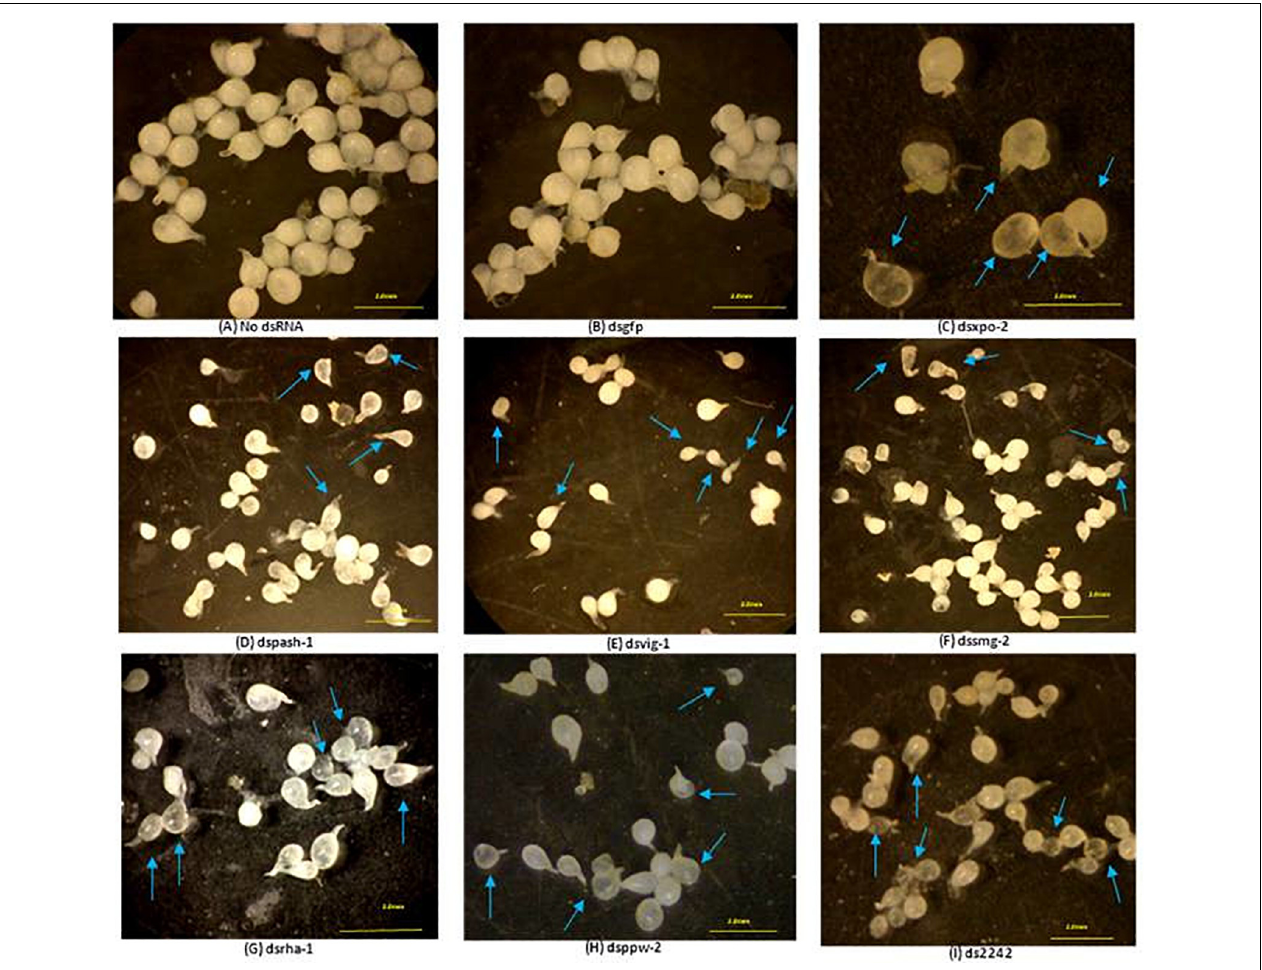
FIGURE 4 | Most significantly affected M. incognita females dissected from tomato roots seven weeks after inoculation with treated J2s. Morphology of females derived from J2s treated without dsRNA (A) , with dsRNA of the gfp gene (B) and with dsRNAs of the nematode genes xpo-2 (C) , pash-1 (D) , vig-1 (E) , smg-2 (F) , rha-1 (G) , ppw-2 (H) , and 2242 (I) . Comparisons were made with females isolated from roots treated with no dsRNA and dsRNA of the gfp gene. Arrows point to malformed or underdeveloped females in different treatments. Scale bar: 2